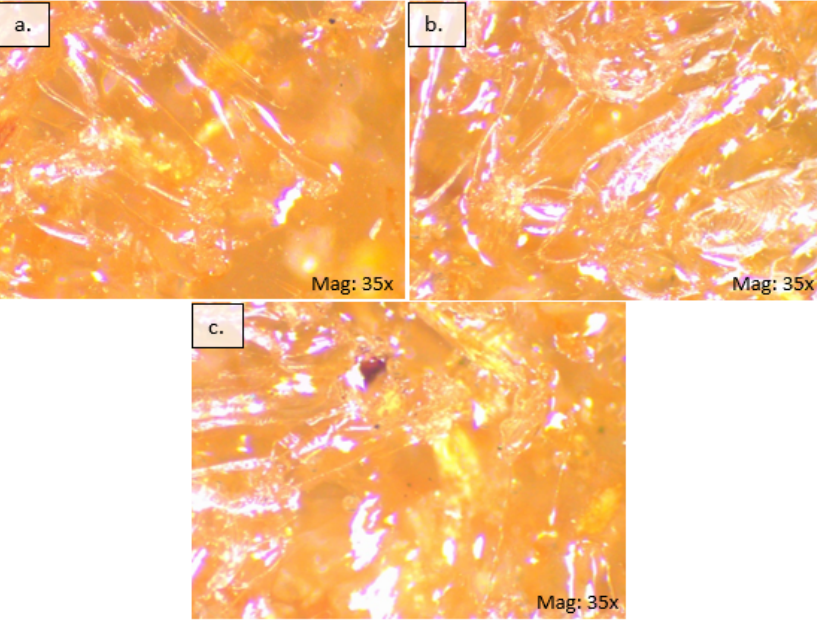
Figure 8. Fracture surfaces of 300 µm filler-reinforced composites under different strain rates: ( a ) 0.00028 s −1 , ( b ) 0.00085 s −1 , and ( c ) 0.0017 s −1 .